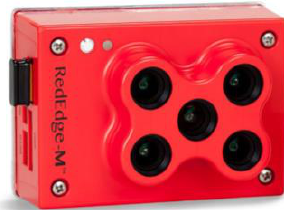
Figure 1: MicaSense RedEdge-M (MicaSense, 2017)